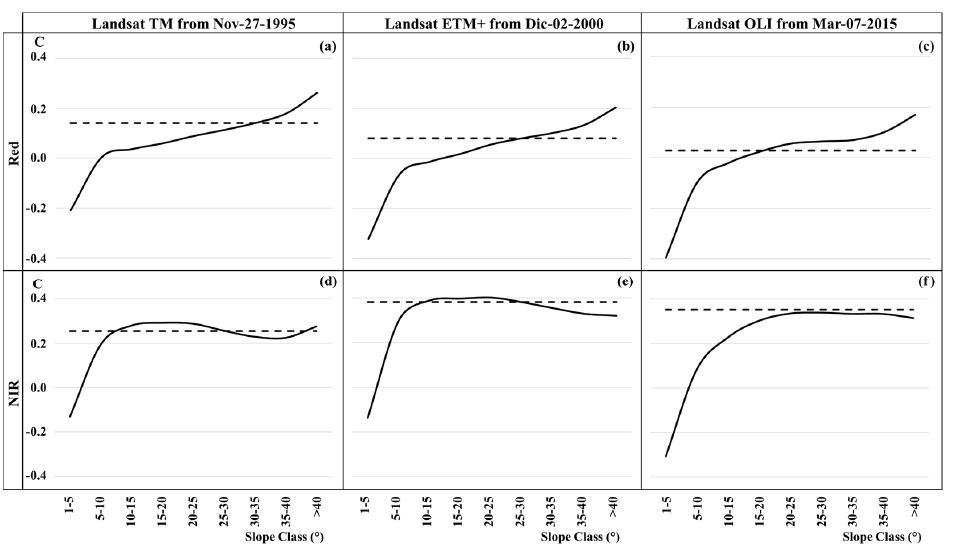
Figure 3. Values of C(i,j) parameters for the red and near-infrared bands, determined by N-SC.